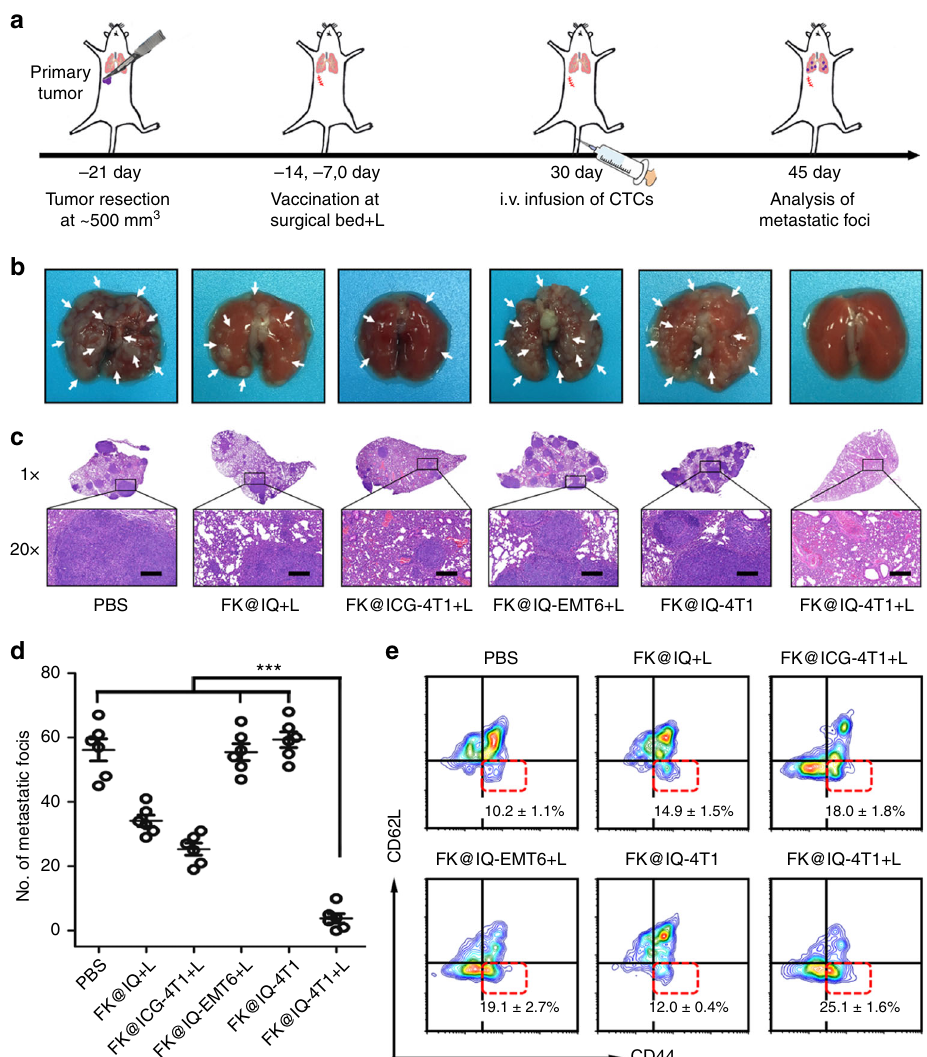
Fig. 7 Metastasis prevention via PVAX-induced long term immune memory effects. a Therapeutic schedule for PVAX-mediated inhibition of tumor metastasis. b Representative photographs of lung tissue. c H&E staining of the lung tissue collected at day 45 (Scale bars = 200 μ m). d Quanti fi cation of pulmonary metastasis nodes on mice pre-vaccinated with different vaccines. The mean metastasis nodes were analysed using one-way ANOVA. *** p < 0.01. Data represent mean ± s.d. ( n = 6). e Flow cytometry plots and proportions of effector memory T cells in the spleen (gated on CD8 + CD11b + ) examined at the same day for i.v. infusion of the the BALB/c mice 3 days post vaccination. The PMBCs and spleen lymphocytes were co-cultured with 4T1, EMT6, or NIH 3T3 cells, respectively. The secretion of IFN- γ by the PMBCs and spleen lymphocytes was then examined by ELISA kits 48 h postincuba- tion. Figure 6h, i demonstrated that the FK@IQ-4T1-vaccinated PMBCs and spleen lymphocytes secreted IFN- γ much more ef fi ciently than FK@IQ-EMT6 + L when co-cultured with the 4T1 cells. In contrast, the combination of FK@IQ-EMT6 + L highly ef fi ciently induced IFN- γ secretion by the PMBCs and spleen lymphocytes when incubated with the EMT6 cells. These results consistently veri fi ed that PVAX induced tumor-speci fi c immune responses, which is essential for personalized immunotherapy.